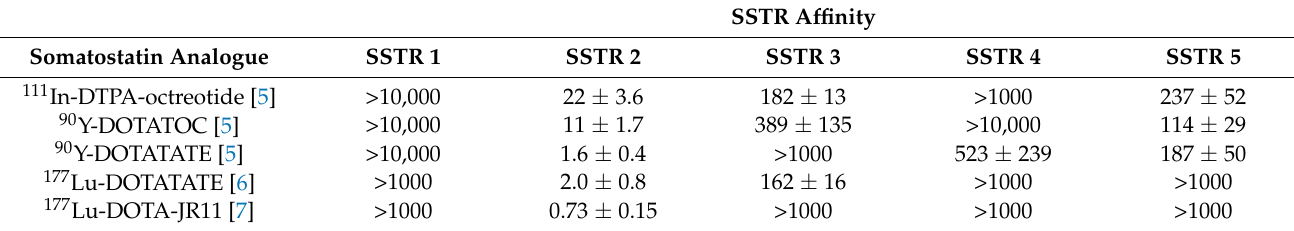
Table 1. SSTR affinity profiles for peptide receptor radionuclide therapy. SSTR